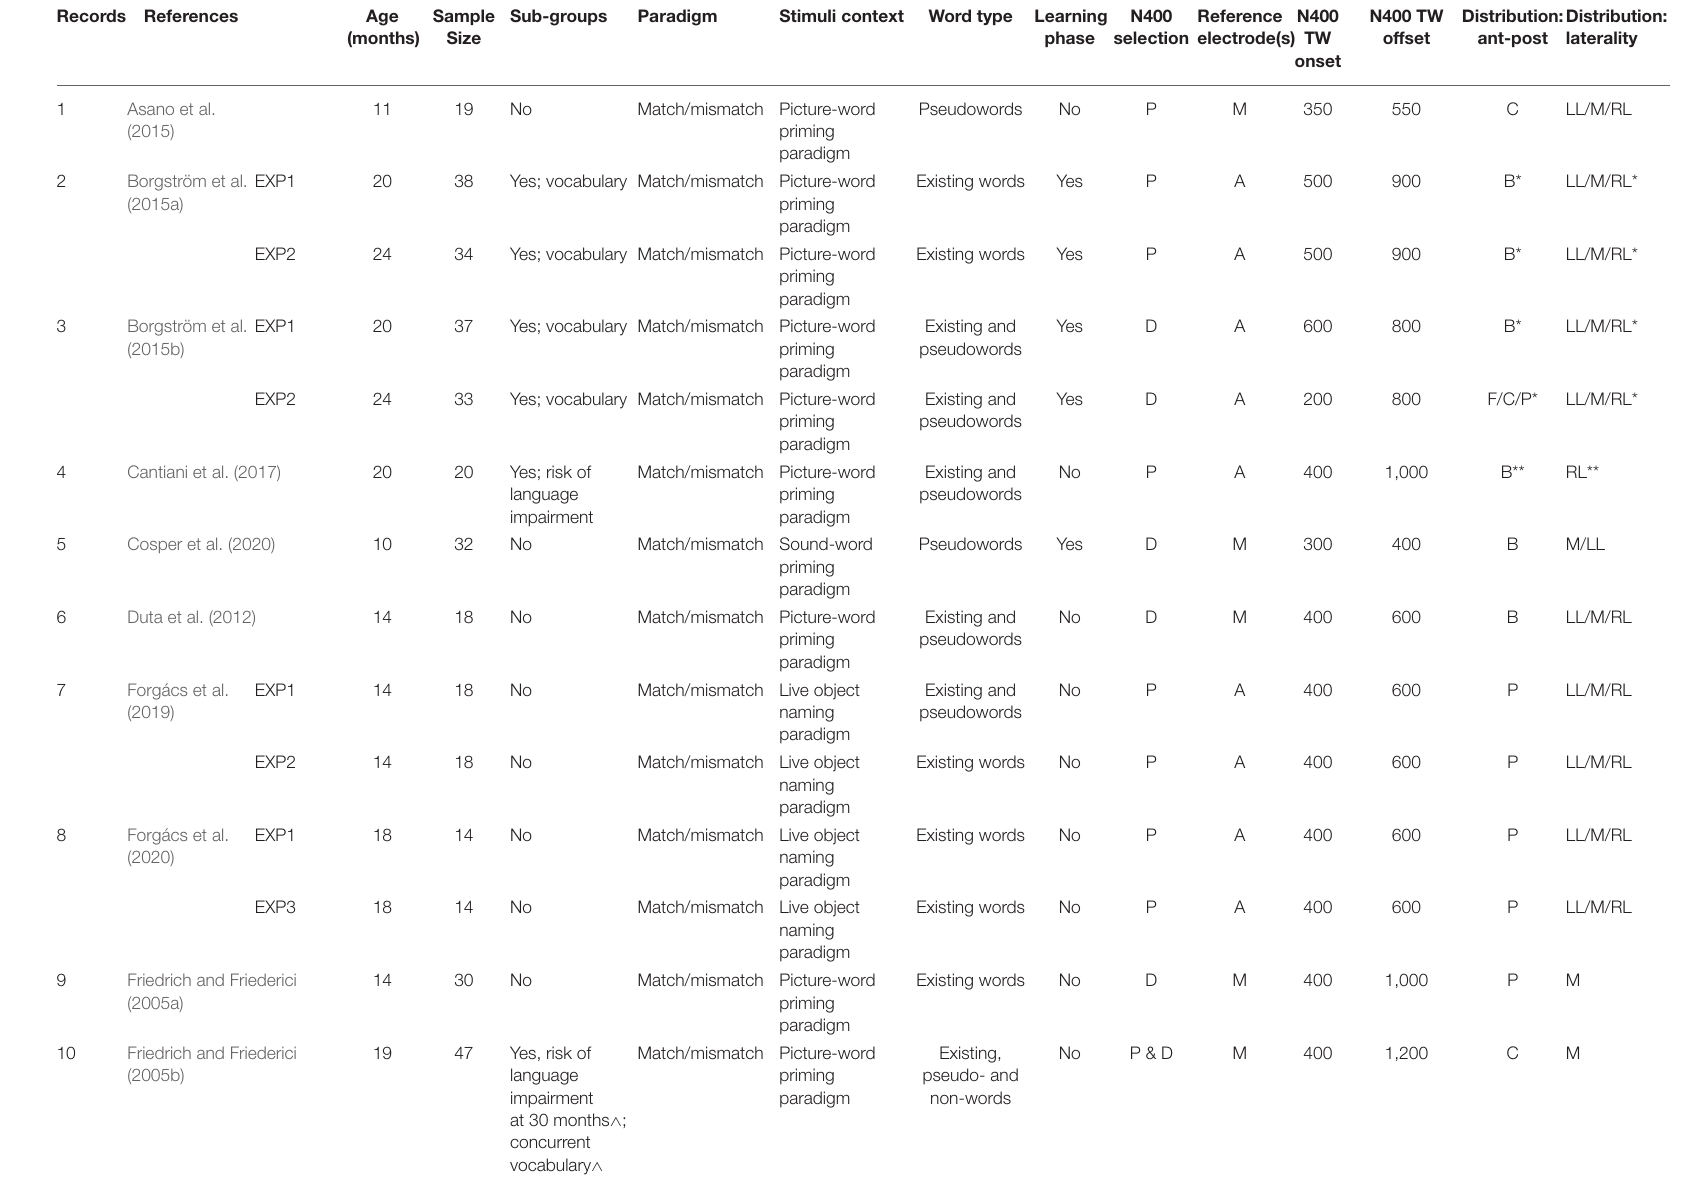
TABLE 1 | List of papers from the literature search that yielded N400